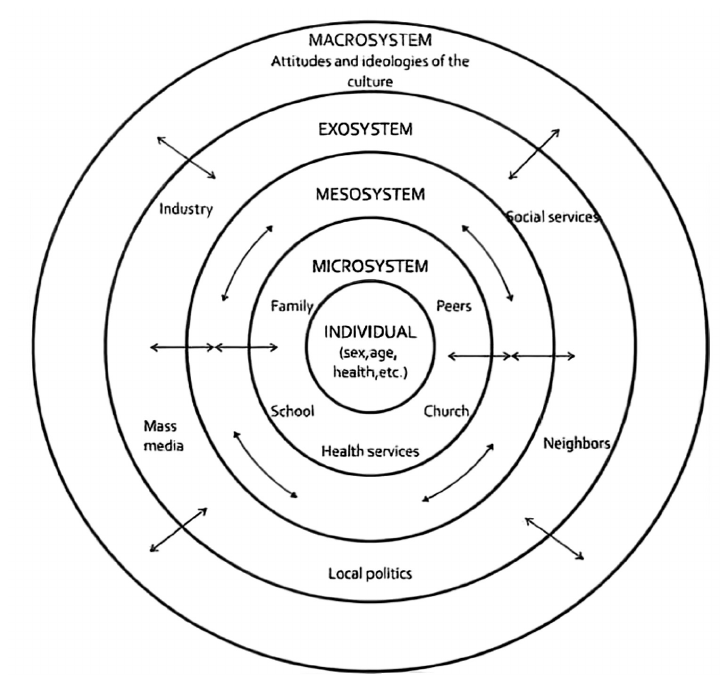
Figure 2. Bronfenbrenner’s ecological systems theory. Source: Bronfenbrenner